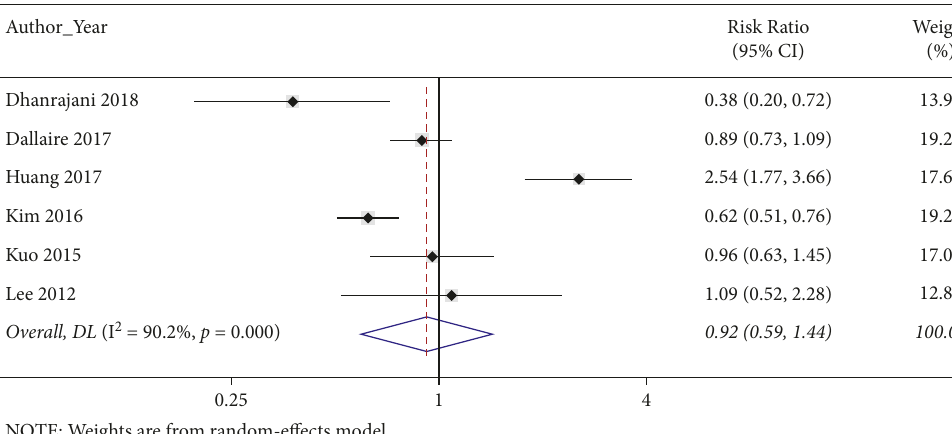
Figure 4: The relative risk of IVIG resistance identified in the meta-analysis from nine enrolled